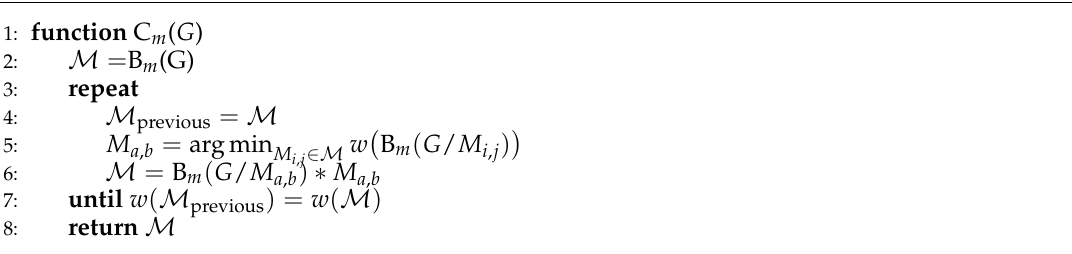
Algorithm 3 (C m , steepest descent based on B m ).